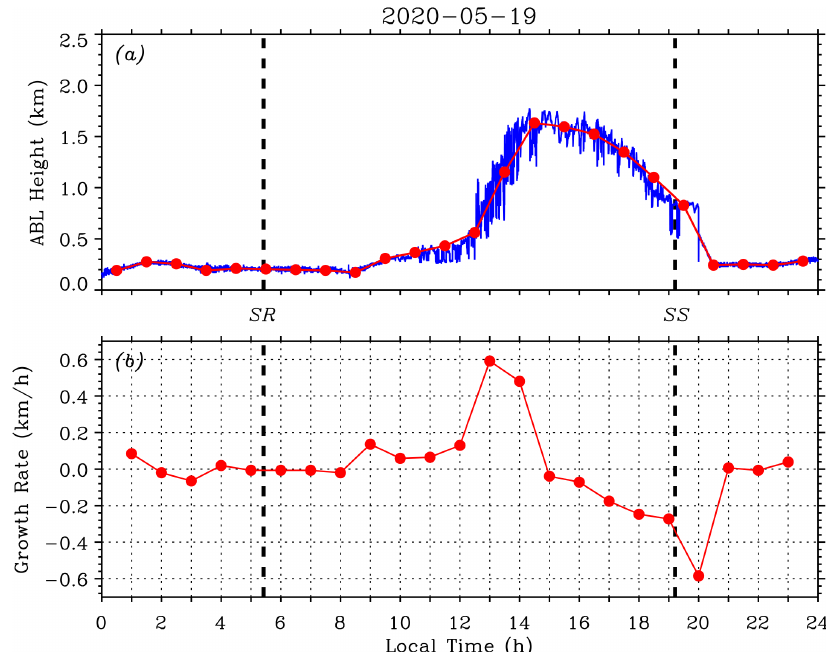
Figure 8. Same as Fig. 5 but on 19 May